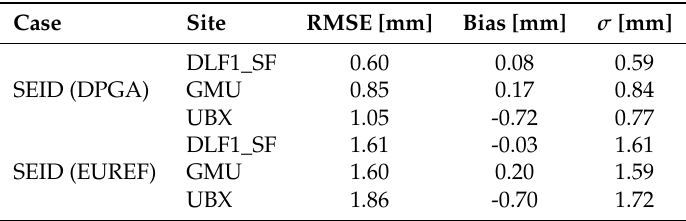
Table 4. RMSE, bias, and standard deviation ( σ ) on the PWV estimation from the SEID-processed solutions using the two SEID constellations DPGA and EUREF utilizing temperature and air pressure measurements from the AWS at the Rotterdam airport (5 km distance) compared to the dual-frequency